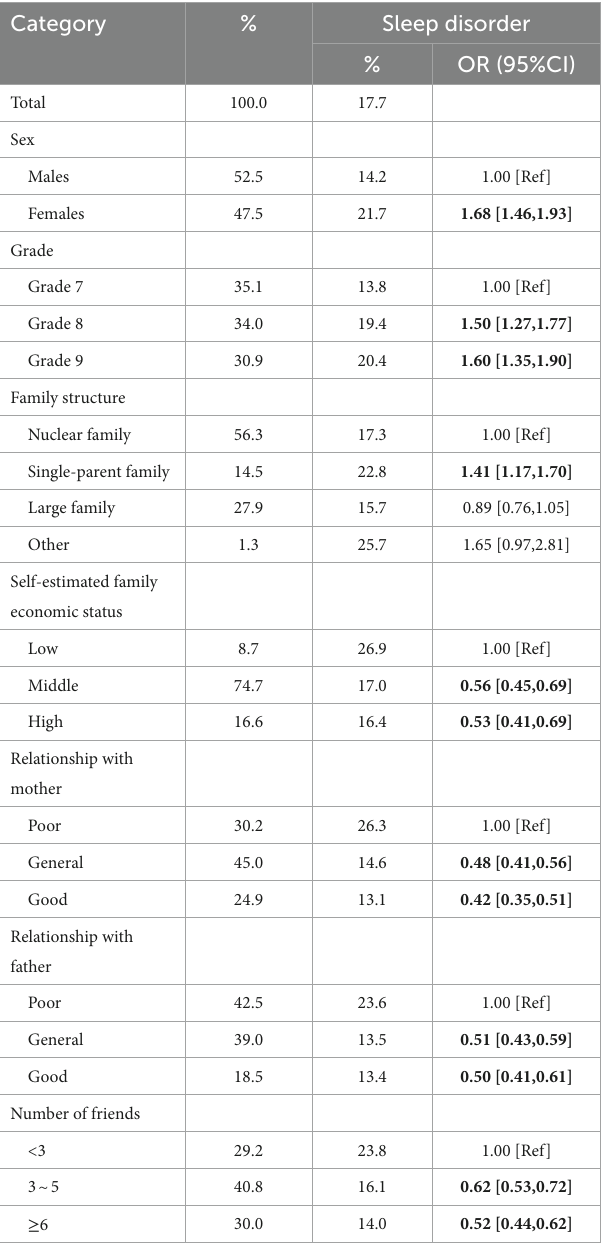
TABLE 1 Unadjusted odds ratios (with 95% CI) for sleep disorder ( N = 5,724).